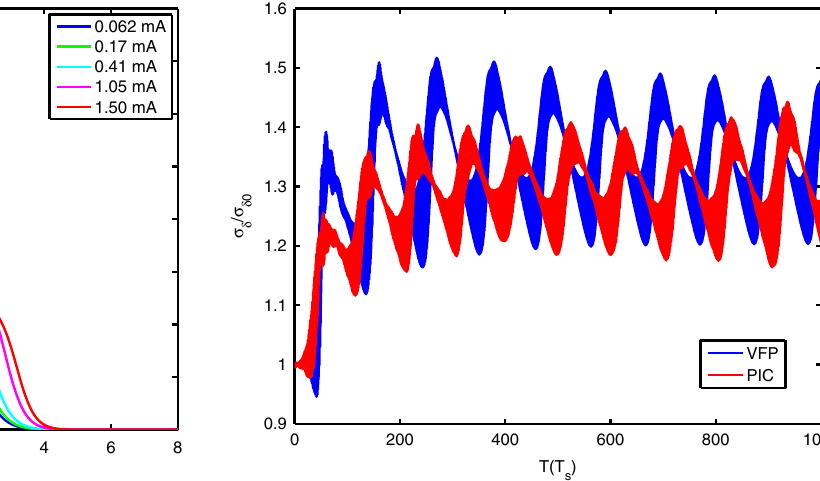
FIG. 1. (Color) Haissinski distributions at various positron bunch currents in the low energy ring of